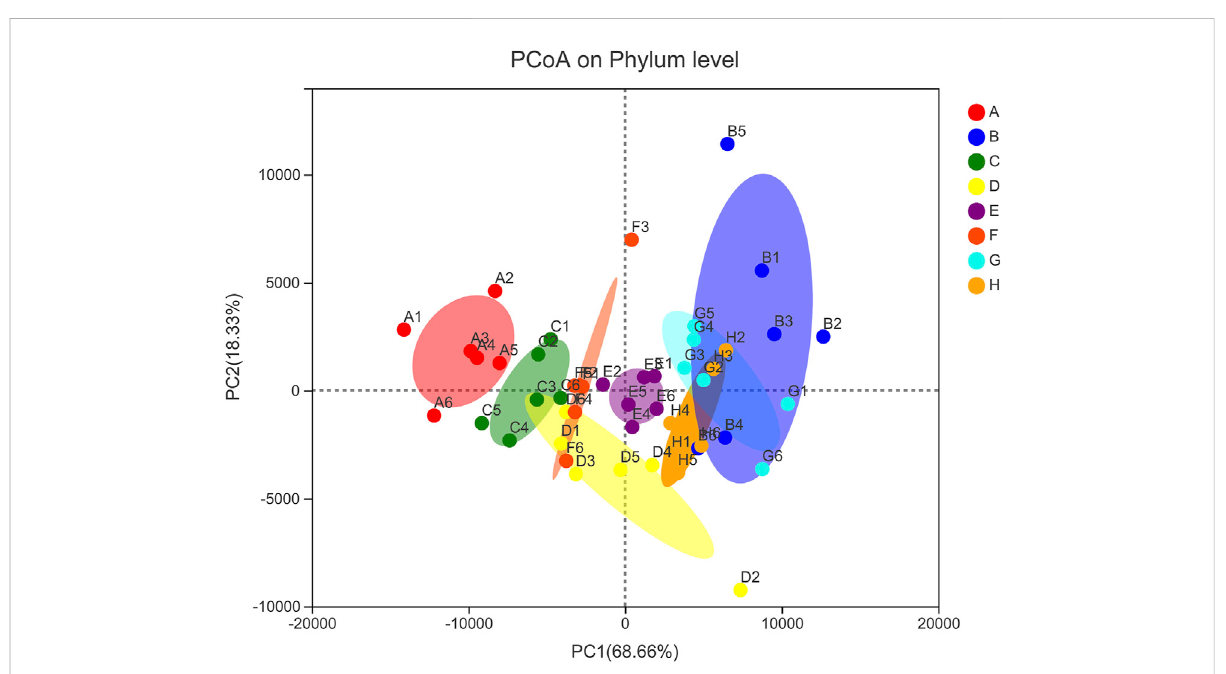
FIGURE 6 Distribution of PCoA scores of intestinal fl ora in rats of each group. Note: A. Blank group B. DN model group C. Irbesartan group D. Cornus of fi cinalis group E. Wine Cornus of fi cinalis group F. Wine honey Cornus of fi cinalis group G. Auxiliary wine group H. Auxiliary wine honey